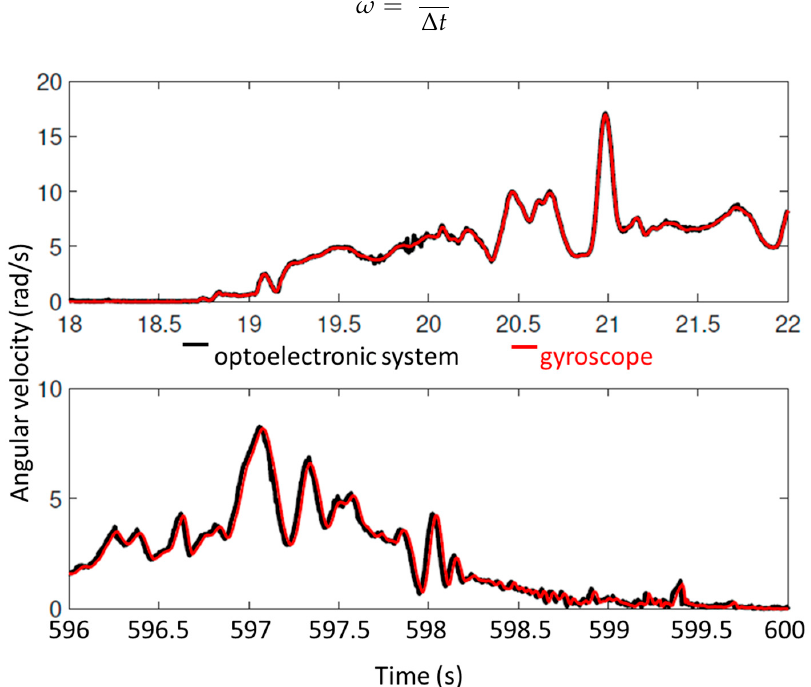
Figure A1. Comparison of the angular velocity obtained from the MIMU (in red) with that obtained from the optoelectronic system (in black) at the beginning of the 10 min acquisition (at the top) and at end (at the bottom).